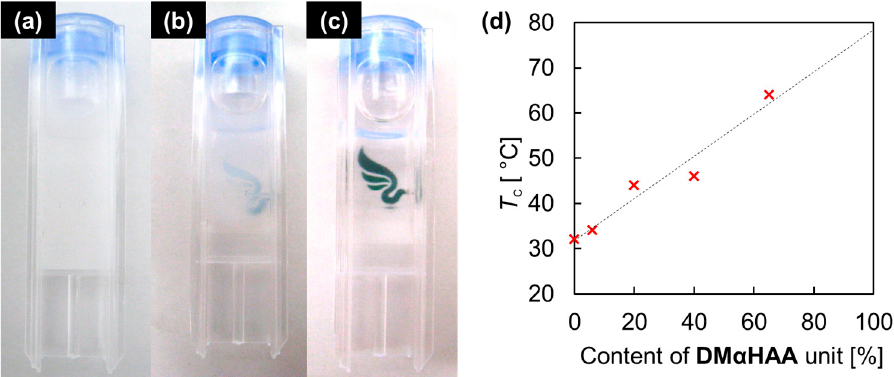
Table 2. Radical (co)polymerizations of DM α HAA with DEAA and the cloud points of the resulting polymer.